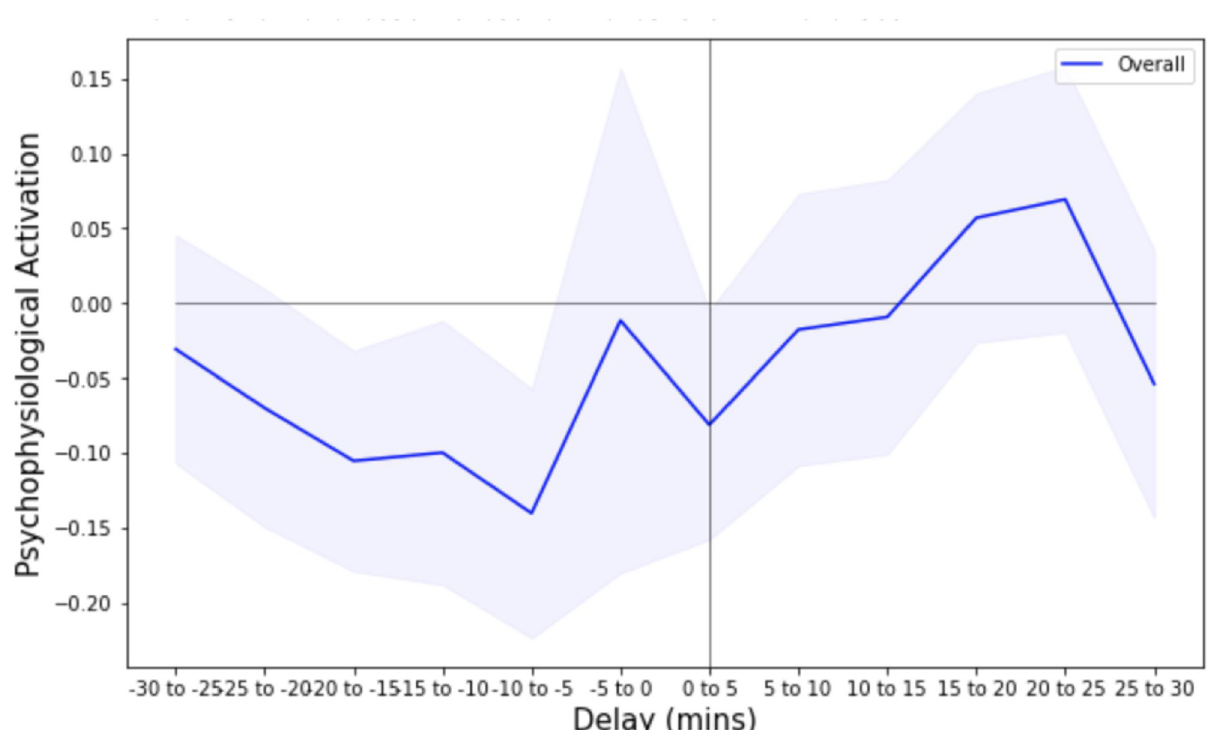
Fig 2. Evolution of trader’s PP activation around a transaction. The shaded region corresponds to the 95% confidence band. The x-axis is the time difference (in minutes) between the transaction time, defined as time 0, and measurement time. The y-axis is the average PP activation value. We observe that traders have the highest PP activation during 15 to 25 minutes after the transaction, as well as a local peak 5 minutes before the transaction.